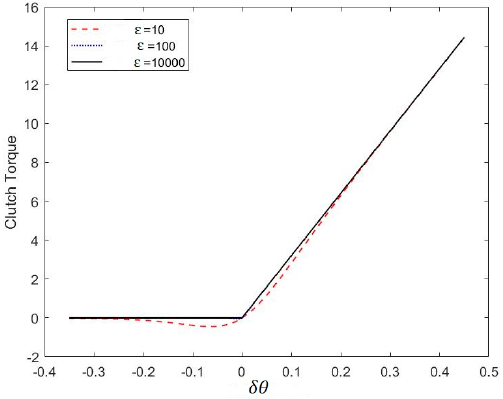
Figure 4. The clutch torque (smooth function) with different smooth constants.